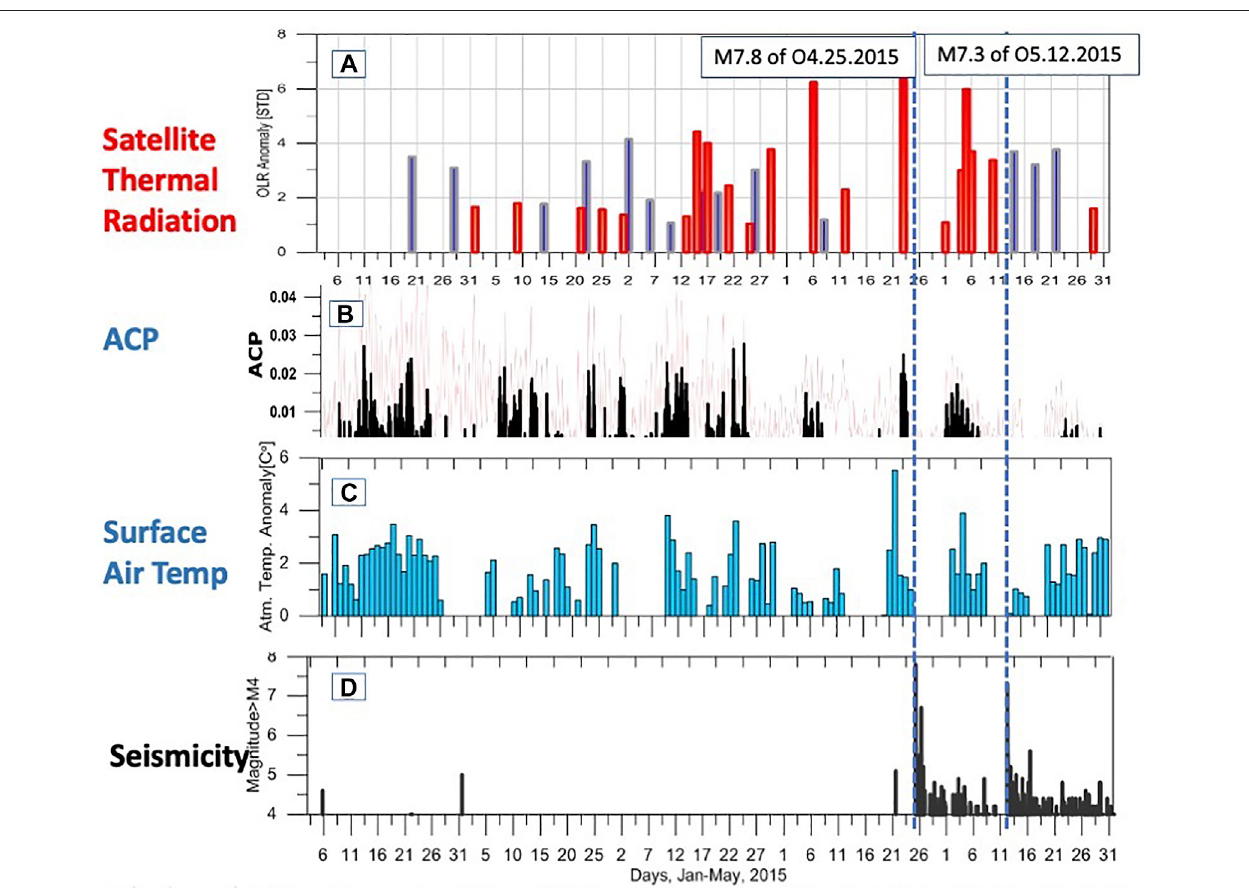
FIGURE 2 | Time series of atmospheric variability observed within a 200 km radius of the Nepal earthquake (top to bottom) : (A) Nighttime anomalous OLR over epicentral region from January 1 – May 30, 2015 observed from NOAA AVHRR (red). Same location, same period a year before - Jan-Ma y 20 14 (black); (B) ACP time series over the epicentral areas. With pink color 2015 ACP 6 hourly data. With black the residual of 2015-20 14 6 hourly ACP data; (C) Air temperature anomaly from station Tribhuvan International Airport (blue) at 0600LT; (D) Seismicity (M > 4.0), Jan – May 2015 within 200km radius of the M 7.8 epicenter (USGS).